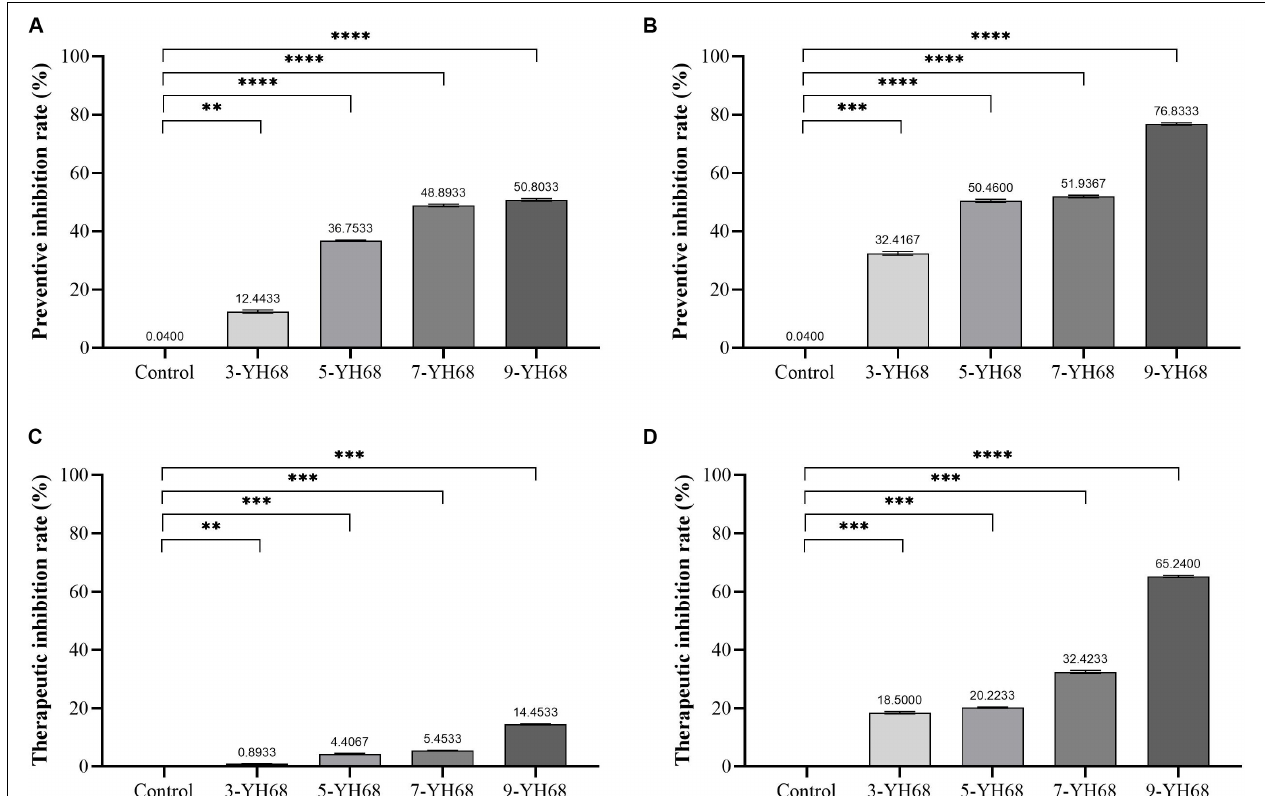
FIGURE 1 | Inhibitory effects of YH68 at different doses against C. difficile growth. (A) Preventive inhibition rate of YH68-cell, (B) Preventive inhibition rate of YH68-CFCS, (C) Therapeutic inhibition rate of YH68-cell, (D) Therapeutic inhibition rate of YH68-CFCS. (Sterile water is used as a control, ∗∗ P < 0.01, ∗∗∗ P < 0.001, and ∗∗∗∗ P < 0.0001; Dunnett’s multiple comparisons test).